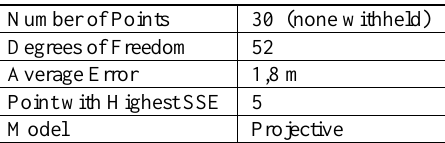
Table 1. Errors for projective transformation